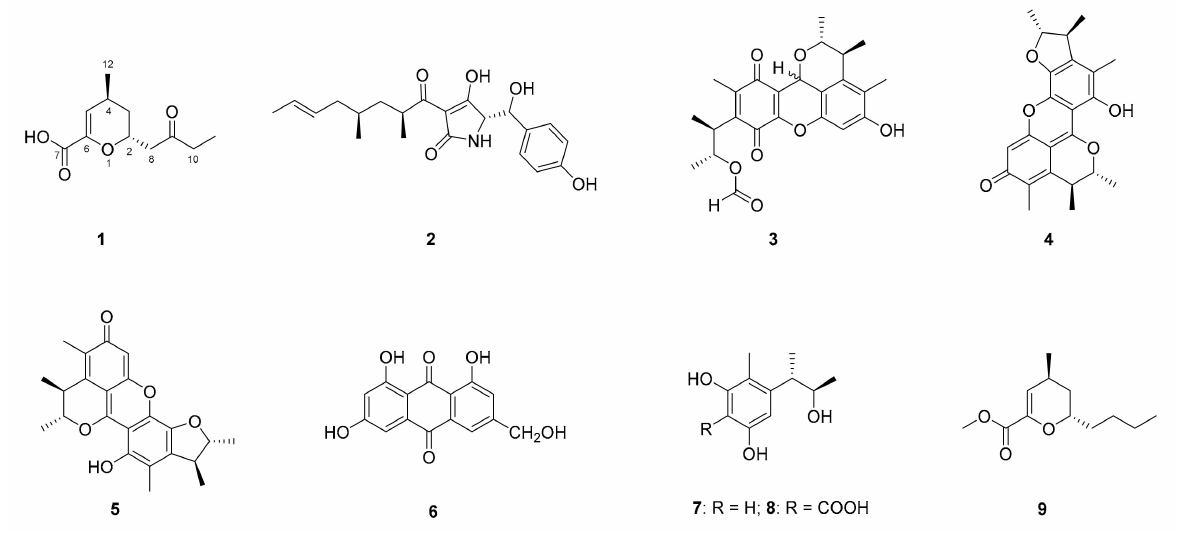
Figure 1. Chemical structures of compounds 1 – 9